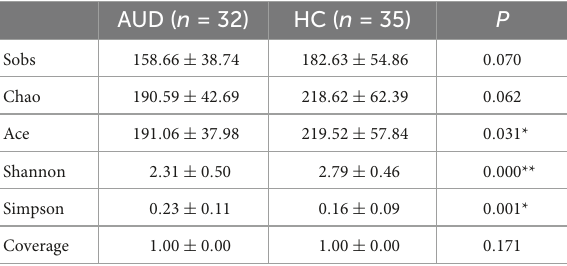
TABLE 4 Comparison of the alpha diversity index in the two